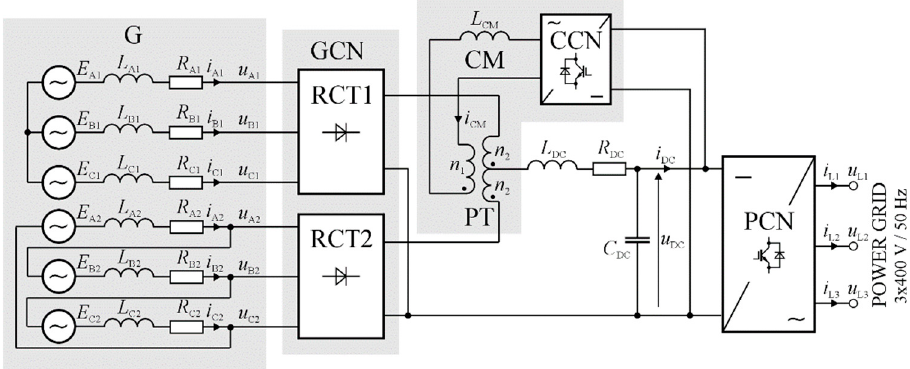
Figure 6. Diagram of model of the novel system (MNS) used in the simulation studies.